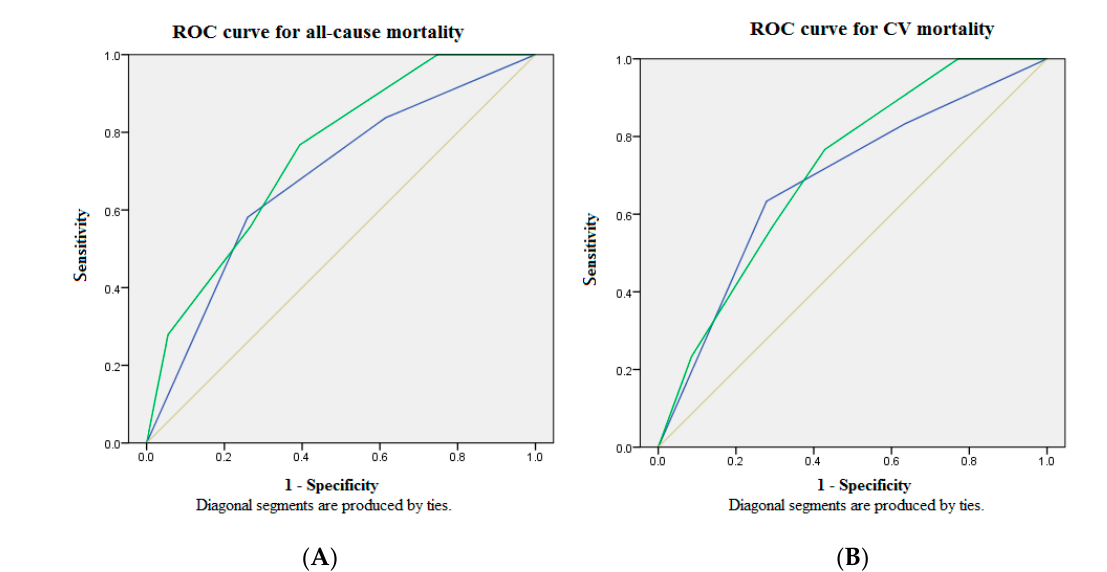
Figure 3. The ROC analysis of the GDF15-based risk score model showed optimal discriminatory power with comparison to GDF15 tertiles in the whole study population over 30 months of follow-up. ( A ) The AUC provided by GDF15 tertiles and the GDF15-based risk score model for all-cause mortality was 0.681 (95% CI = 0.589 to 0.774) and 0.745 (95% CI = 0.666 to 0.824), respectively. ( B ) The AUC provided by GDF15 tertiles and the GDF15-based risk score model for CV mortality was 0.684 (95% CI = 0.577 to 0.791) and 0.715 (95% CI = 0.625 to 0.805), respectively. Source of the curve: green line = GDF15-based risk score model; blue line = GDF15 tertiles; yellow line = reference. AUC = area under curve; CV = cardiovascular; GDF15 = growth differentiation factor-15; ROC = receiver operating characteristics.